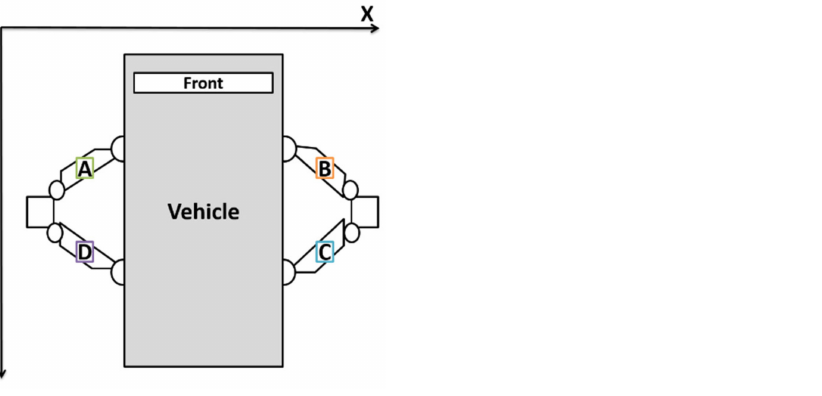
Figure 4. Identification of lift arms and orthonormal coordinate system used for